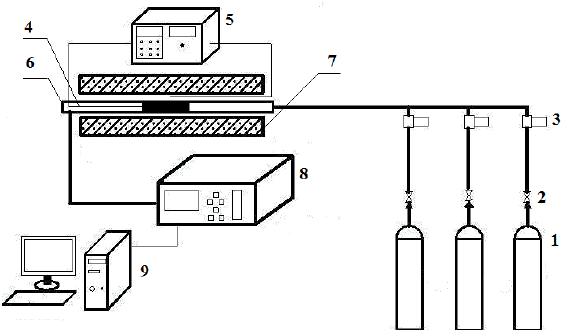
Figure 1. Diagrammatic sketch of a fixed-bed reaction system: (1) Gas cylinder, (2) valve, (3) mass flow controller, (4) thermocouple, (5) temperature controller, (6) quartz reactor, (7) horizontal tube furnace, (8) gas analyzer, and (9) data acquisition system.